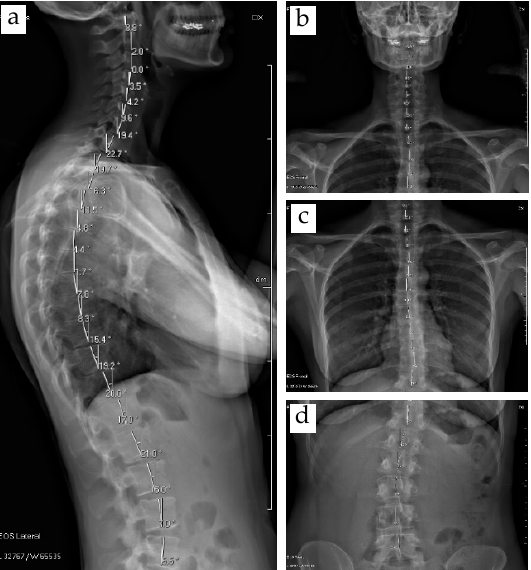
Figure 20. The EOS medical images of ( a ) sagittal angles and ( b – d ) coronal angles.